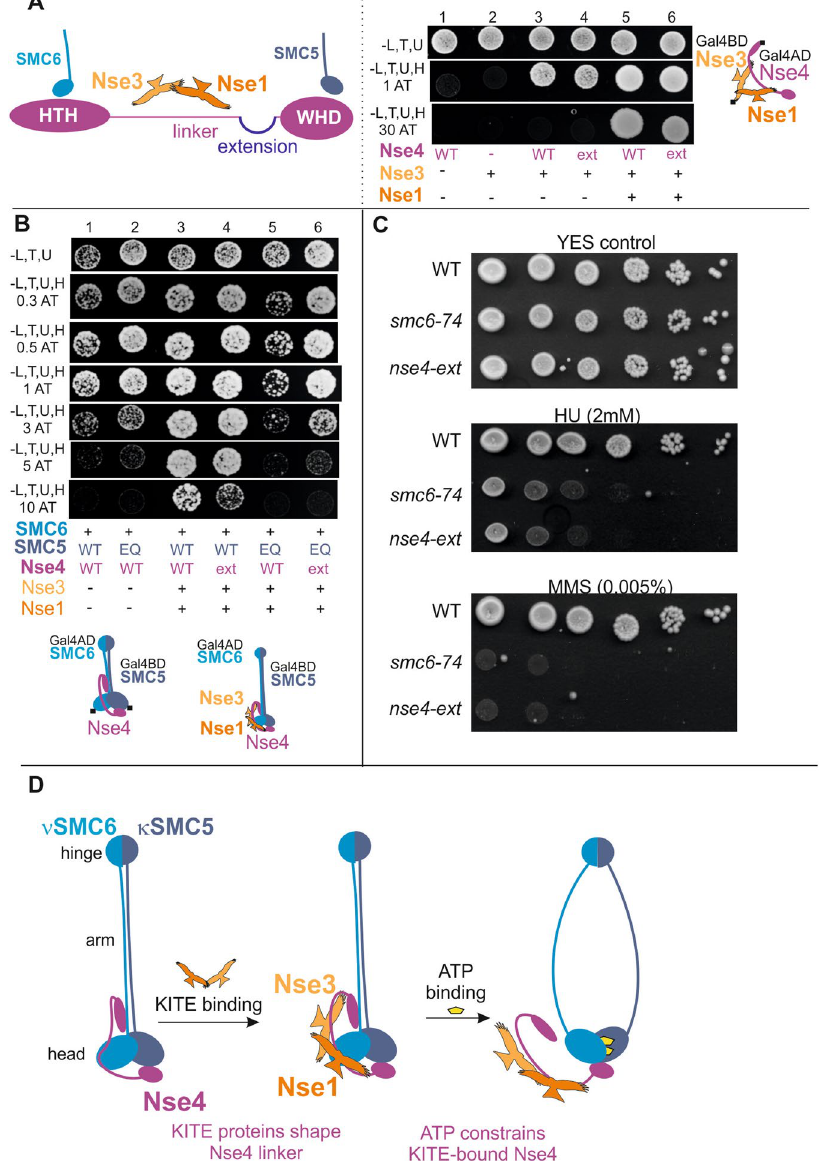
Figure 5. The limited size of the Nse4 linker poses mechanical constraint. ( A ) Schematic representation (left panel) of the Nse4 regions with their binding partners (depicted above). The 30 amino acid extension is inserted at the end of the linker (after aa174; Suppl. Fig. S4A). In the control experiments (right panel), the 30 amino acid extension (ext) does not affect the stability of either Nse3-Nse4 binary interaction (column 4) or Nse1-Nse3- Nse4 trimer (column 6). ( B ) The stability of the ATP-free SMC5-SMC6-Nse4-Nse3-Nse1 complex containing nse4/WT or nse4/ext is comparable (columns 3 and 4), while the extension of the linker results in the partial relief of the ATP-induced tension in the SMC5/E995Q complex (compare columns 5 and 6). ( C ) The S. pombe smc6-74 and nse4/ext hypomorphic mutants were tested for sensitivity to hydroxyurea (HU) or methyl methane sulfonate (MMS) using tenfold serial dilutions. ( D ) The schematic summary of the roles of the KITE subunits in the ATPase cycle of SMC5/6. Our data show that the SMC5/6 core complex is less stable in the ATP-bound state than in the ATP-free state. We hypothesize that the KITE-shaped Nse4 linker fits the ATP-free conformation of SMC5/6 (and therefore increases its stability), while the ATP-bound conformation is less compatible with the KITE-shaped Nse4 linker (and therefore constrains the Nse4 bridge). The reduced stability of the ATP-bound complex may suggest that one or more protein-protein interaction interfaces are compromised upon ATP binding. The results in the Fig. 3 suggest that the Nse4-SMC6 interface might be open. The results in the Fig. 4 also point to the Nse4-Nse3 interface. In addition, the interface between SMC5-SMC6 arms might be disturbed upon the ATP binding as suggested for the other SMC complexes. The stiff KITE-bound Nse4 linker may transduce a pulling force generated by the binding of ATP to the SMC5-SMC6 heads. In consequence, the Nse4- SMC6 and Nse4-Nse3 interfaces may open and release the Nse4